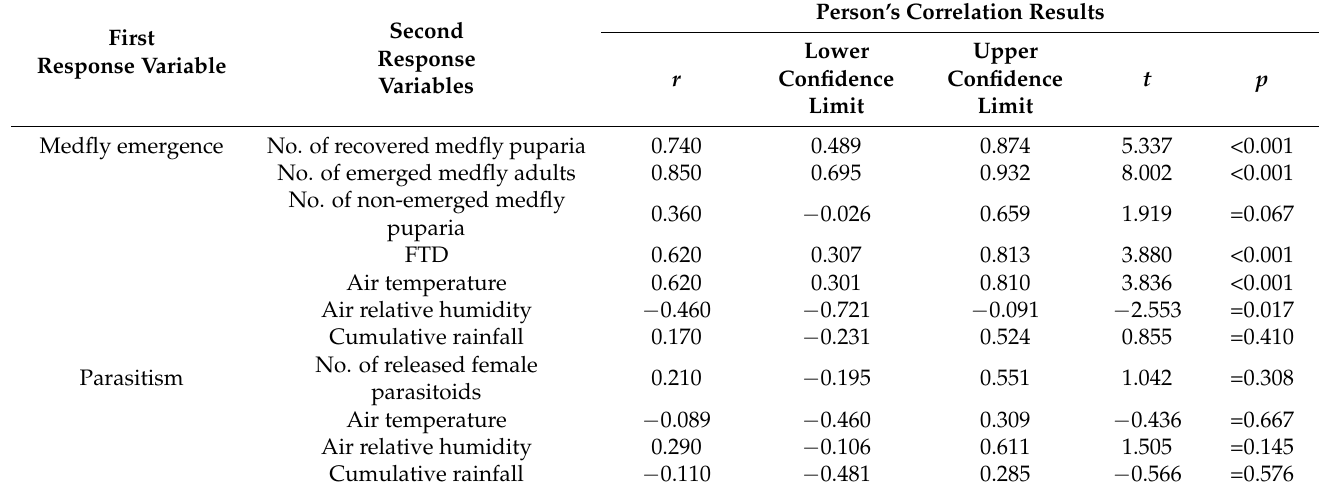
Table 2. Summary of Pearson’s correlations between variables based on the averaged database by release period. The medfly ( Ceratitis capitata ) and parasitoid ( Diachasmimorpha longicaudata ) vari- ables correspond to the correlations under non-parasitoid release and parasitoid release conditions,